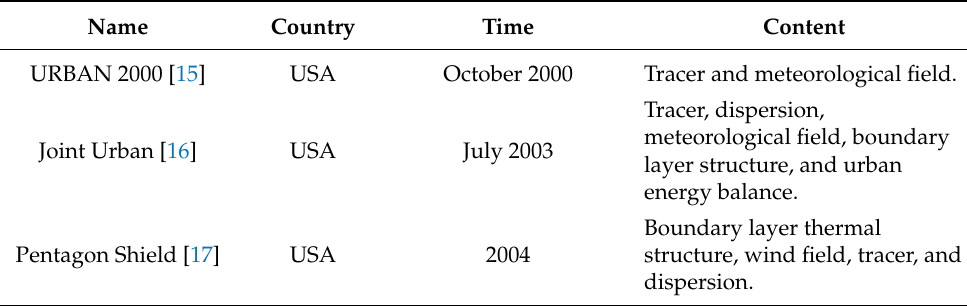
Table 1. Short-term urban meteorological observation